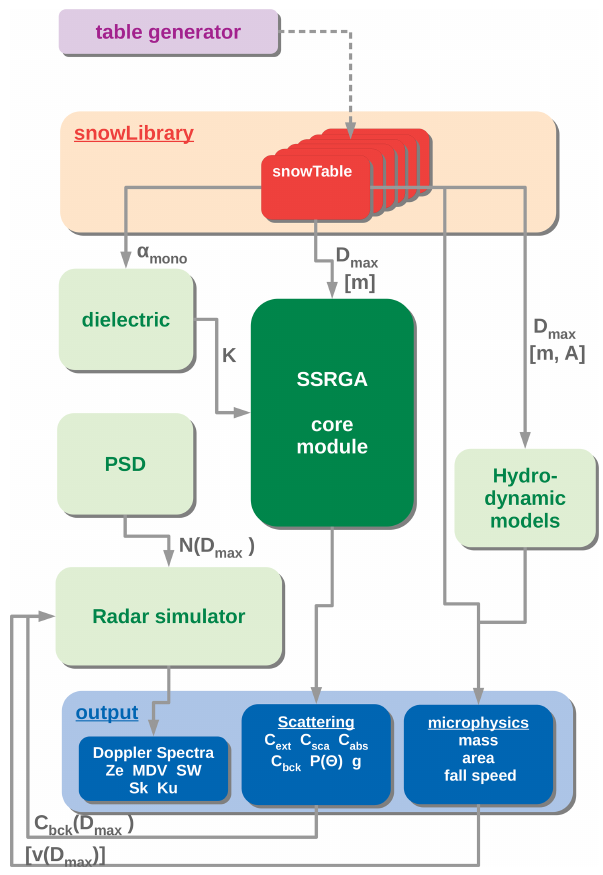
Figure 2. Schematics of the modules included in the snowScatt package and basic workflow. The various components are color- coded according to their primary use. The reddish and green blocks respectively identify the data and algorithmic components of the package. The auxiliary “table generator” package, which can be used to extend the snowLibrary database, is colored in violet. Even though the output is not technically a module of the snowScatt pack- age it is highlighted here in blue. The text along the connection lines describes the variables that are passed to the connecting module. The only independent variable for single-particle computations is D max , which can be used to calculate the mass m , cross-sectional area A , and the fall velocity v . However, these three variables are written within squared brackets, indicating that they can also be overloaded at runtime to allow for more flexible applications of the